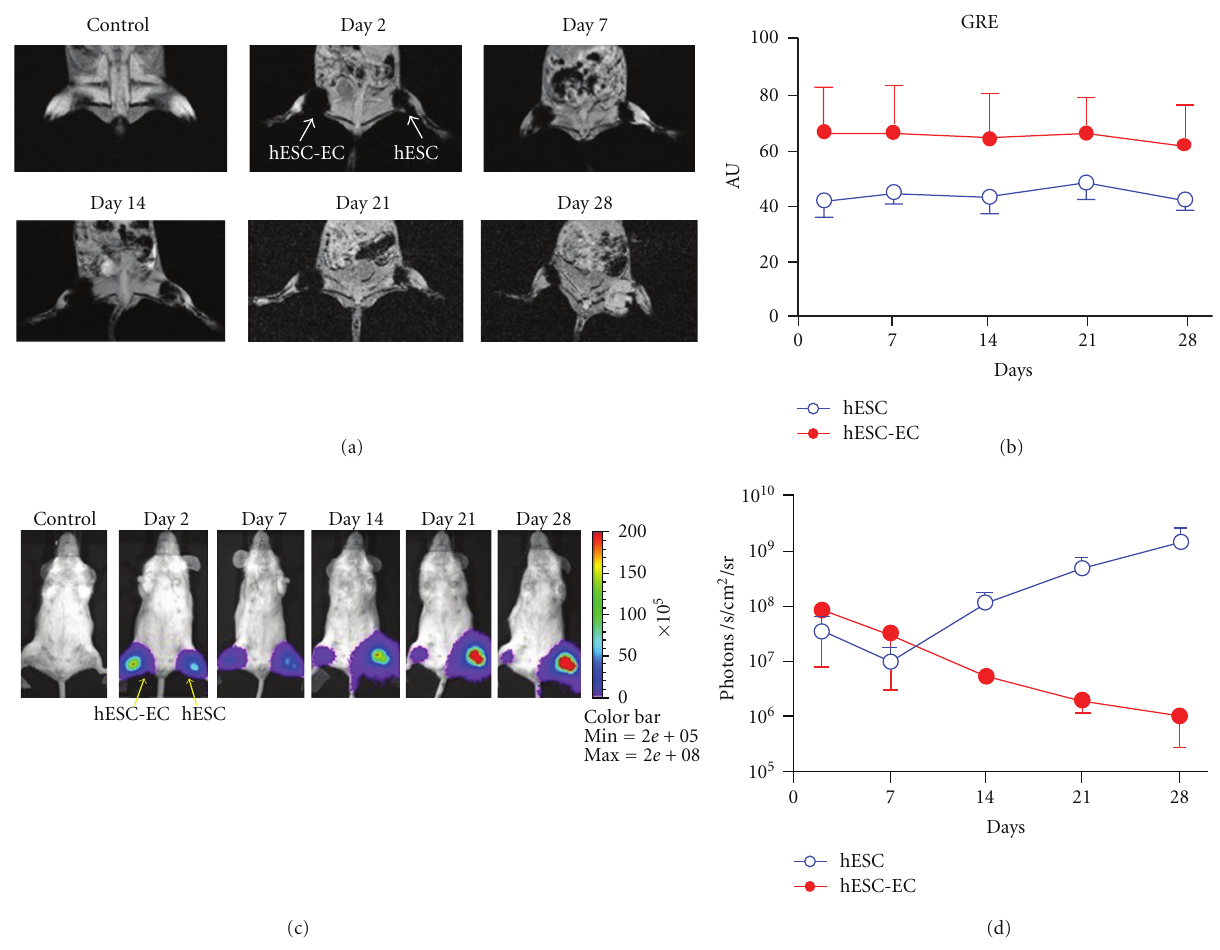
Figure 1: Direct comparison of reporter gene imaging (genetic labeling) versus iron particle imaging (physical labeling) for tracking stem cells. (a) Human ESCs were cultured under normal conditions or on gelatin/fibronection-coated plates to induce endothelial cell di ff erentiation. These predi ff erentiated human ESC-derived endothelial cells (hESC-ECs) and undi ff erentiated ESCs were SPIO-labeled (with Feridex) and 1 × 106 cells were then injected into mouse hindlimbs. MR images of one representative animal show the cells at days 2, 7, 14, 21, and 28. (b) MR does not show survival di ff erences between the two groups, as the signal is steady throughout all imaging timepoints, with a higher signal in the hESC-EC group through day 28. (c) These same ESCs were transduced with the human ubiquitin promoter driving fireflyluciferase (Fluc) and enhanced green fluorescence protein (eGFP). These cells were then cultured as in (a) prior to transplantation into the hindlimb of a mouse. (d) BLI showed divergent survival profiles for the two groups, with proliferation of ESC and acute donor cell death of pre-di ff erentiated hESC-ECs. This study demonstrated that MRI provided detailed information on the anatomical location of cells, but not on cell viability. Reporter gene imaging is a better indicator of cell viability and proliferation [36].